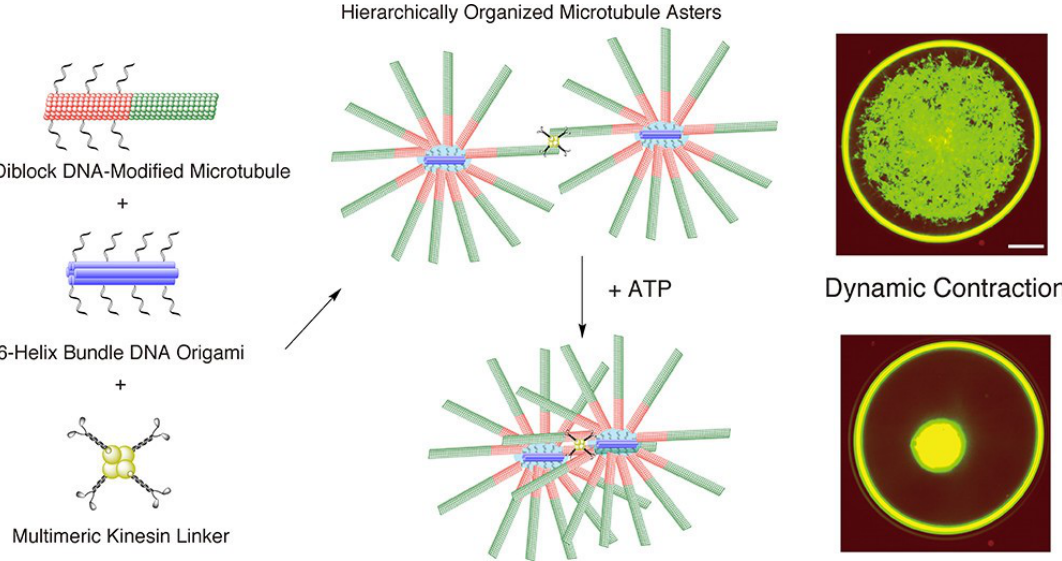
Figure 10. This is a simplified diagram with brief explanations of each of the molecular robot’s components and how each “robot” interacts with one another (Reprinted with permission from Matsuda, K. et al. [85]. Copyright 2019 American Chemical Society).